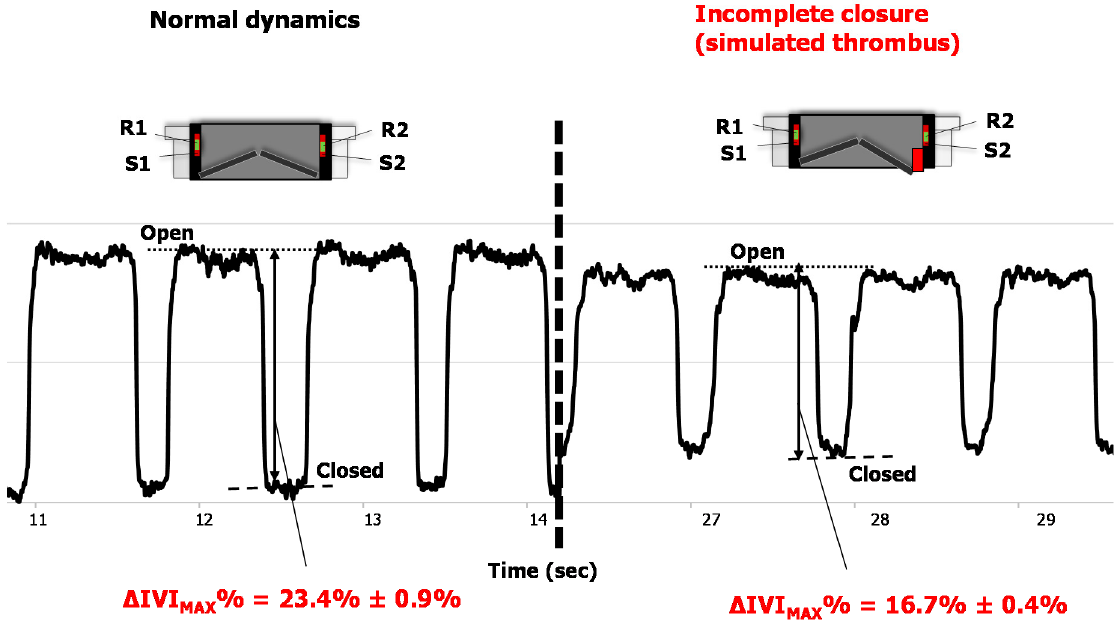
Figure 6. IVI signal recorded during normal opening/closing dynamics ( left ) and during the experimentally reproduced incomplete valve closure ( right ).